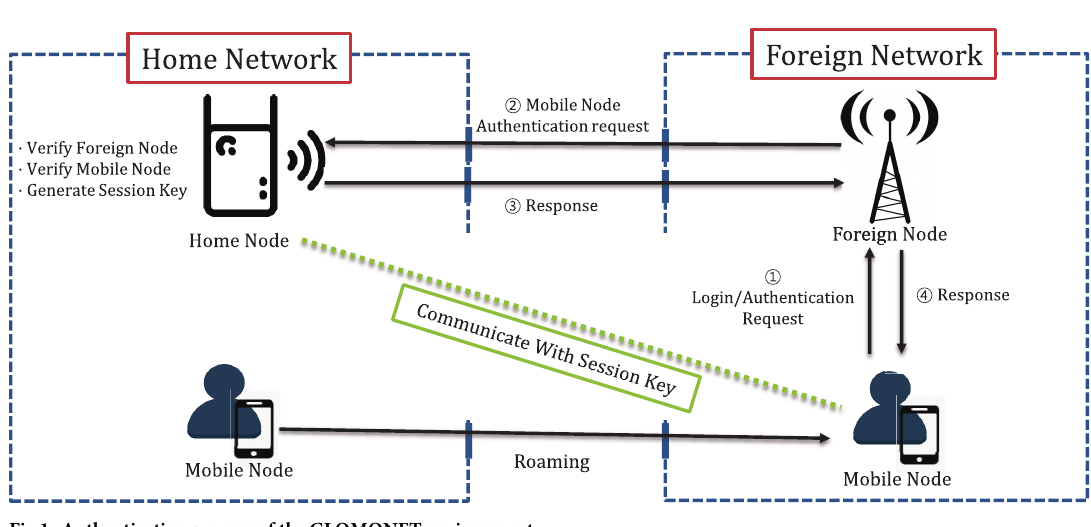
Fig 1. Authentication process of the GLOMONET